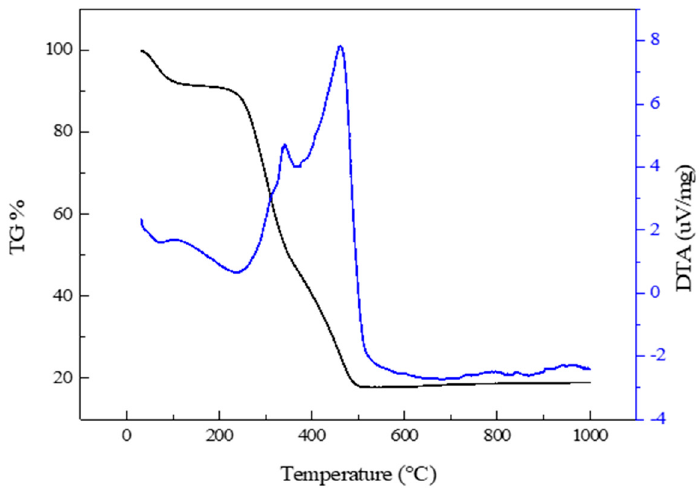
Figure 1. Thermogravimetric (TG), derivative thermogravimetric (DTG), and differential thermal analysis (DTA) curves of rice husk at 30–1000 °C in static air.